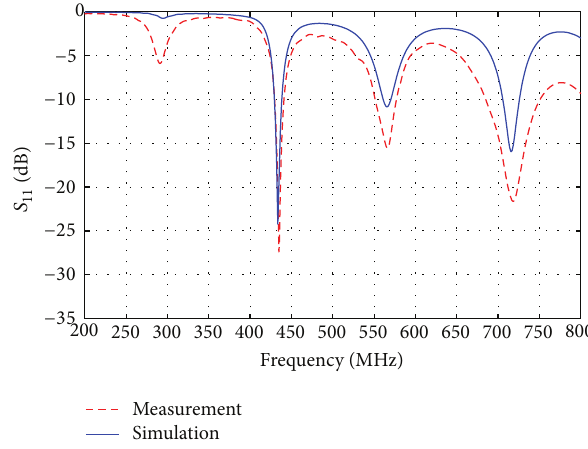
Figure 2: Simulation (solid line) and measurement (dashed line) S 11 values for spiral antenna.